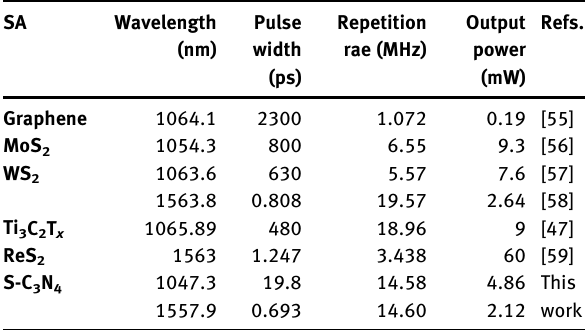
Table  : Performance comparisons of the S-C  N  -based YDF and EDF lasers with some mainstream  D